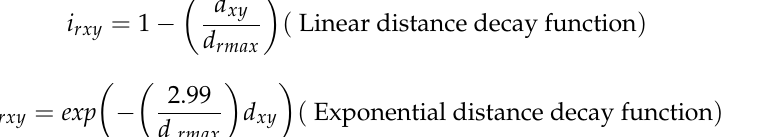
Table 1. Maximum influenced distance and weight of threat factors.